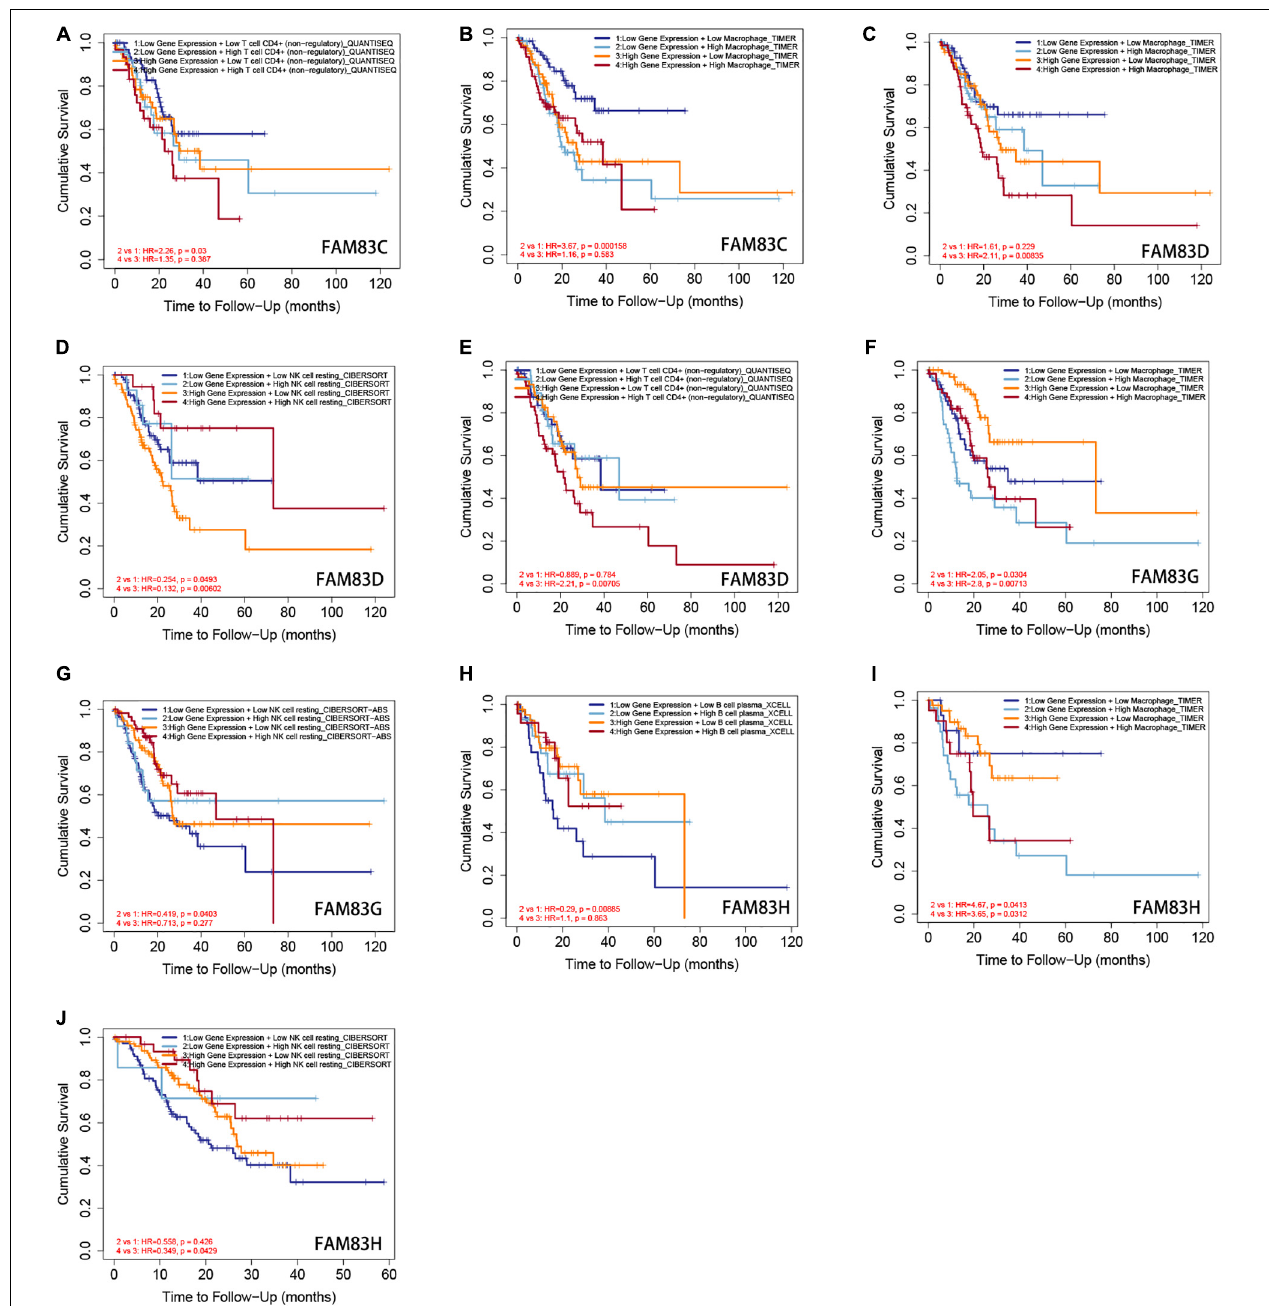
FIGURE 13 | (A–J) The Kaplan-Meier curves for the immune infiltrates, expression level of FAM83C/D/G/H and STAD. The infiltration level is divided into low and high levels, and the hazard ratio and p -value for Cox model and the log-rank p -value for KM curve were shown on the KM curve plot